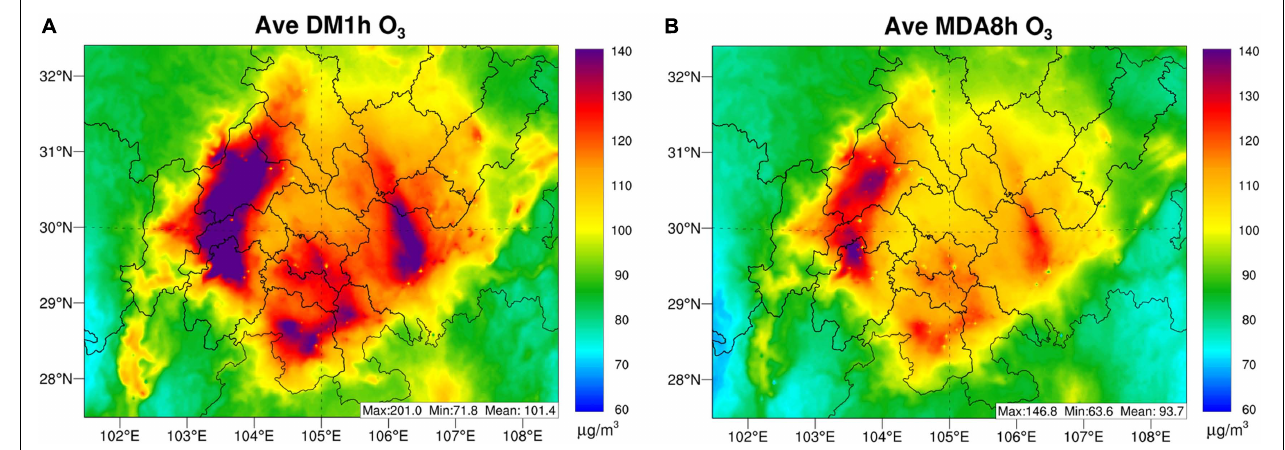
FIGURE 6 | Spatial map of daily maximum hourly O 3 concentrations (DM1h O 3 ) and daily maximum 8-h average (MDA8) O 3 concentrations in July 2017.